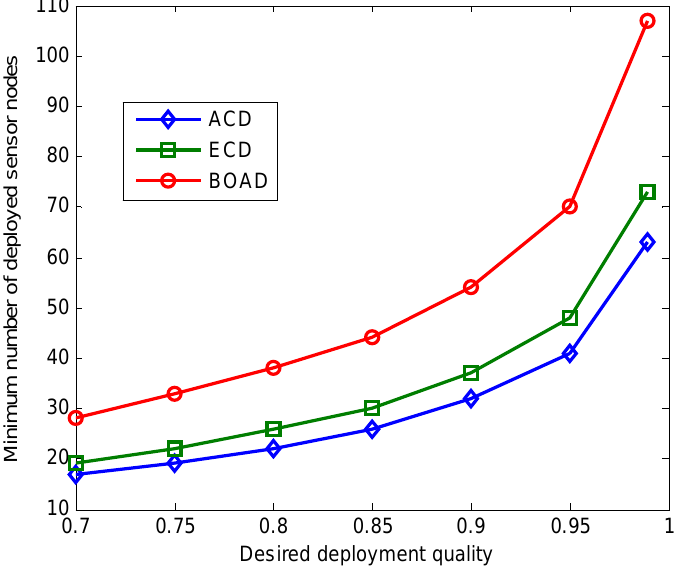
Figure 3. The minimum number of sensors deployed to meet desired deployment